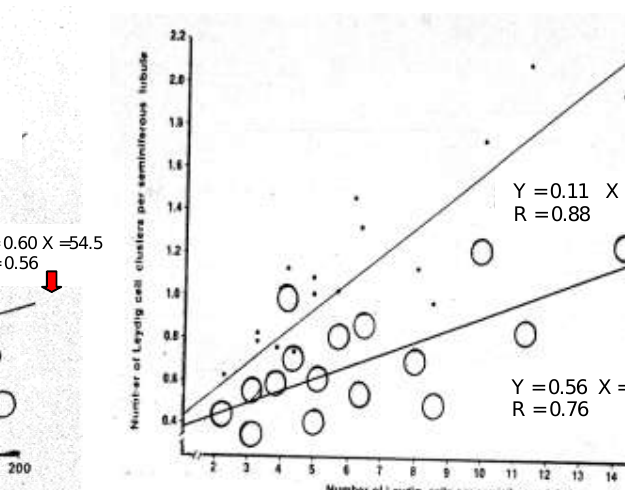
Fig. (2) Correlation of each Gossypol and control groups in correlation between mean number of Leydig cell clusters per seminiferous tubule (P < 0.01).